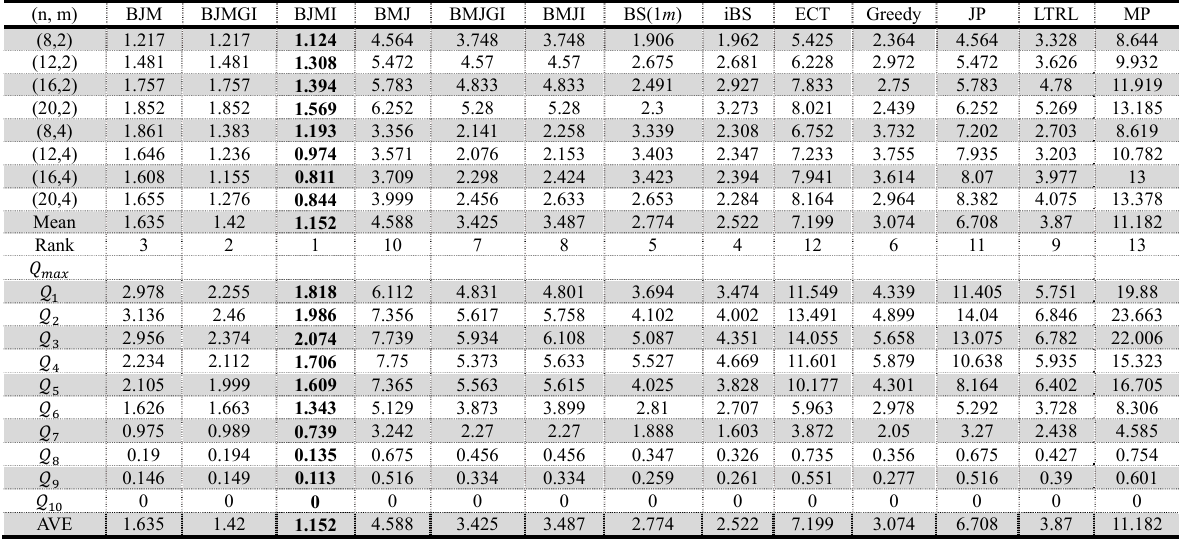
ARPI for heuristics(small instance)